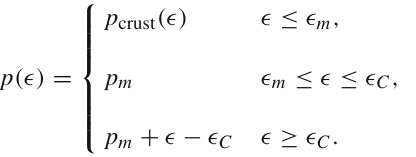
= 2 M (cid:3) the absolute minimum period is 0.39 Thus, for M max sph